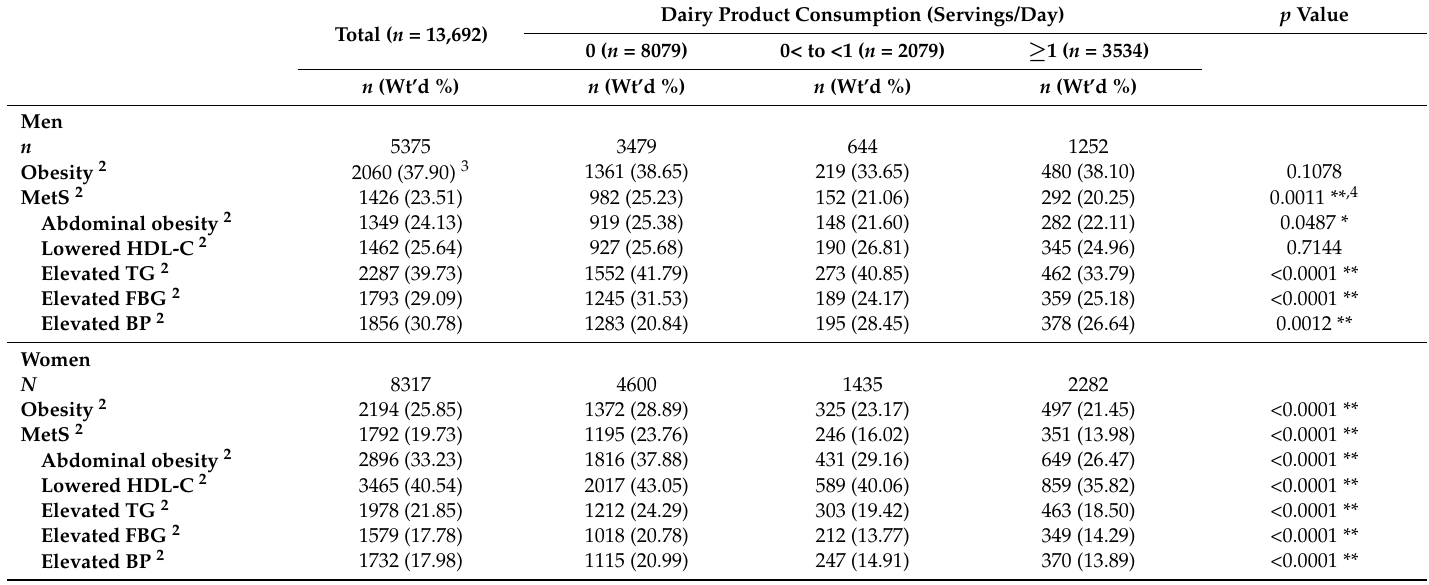
Table 4. Prevalence of obesity, metabolic syndrome, and its components according to dairy product consumption in Korean adults, KNHANES 2010–2013 1 .